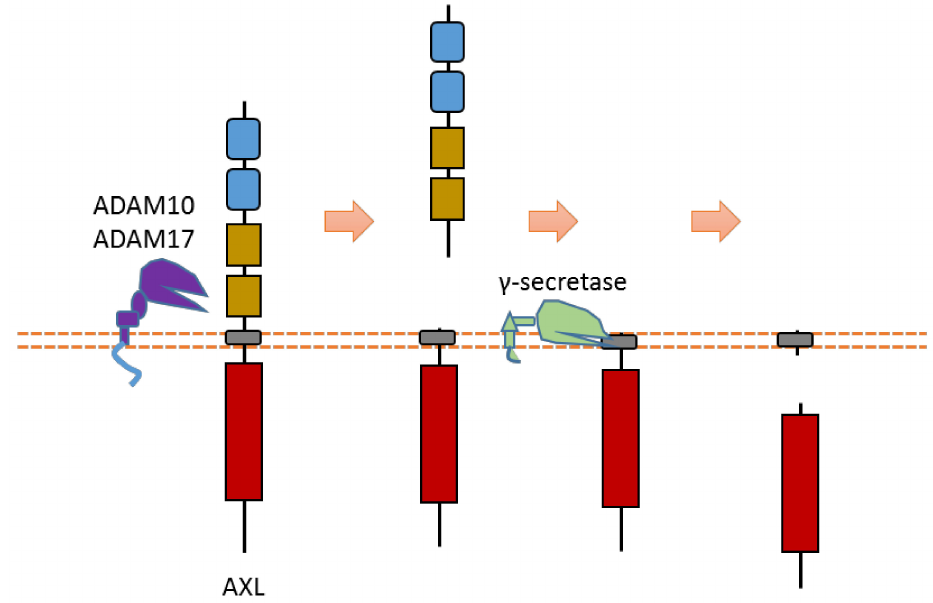
Figure 3. Schematic illustration of proteolytic cleavage in